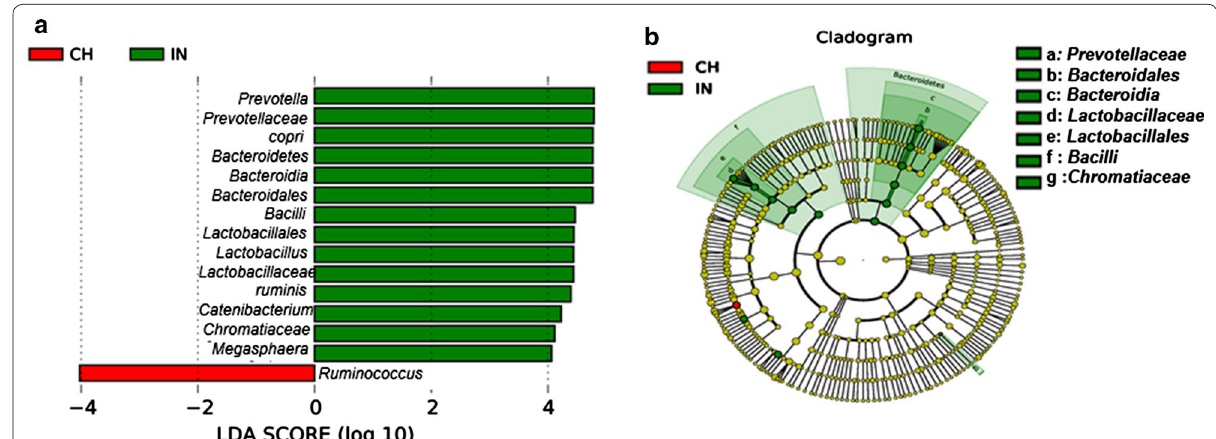
Fig. 6 LEfse analysis identified gut bacterial biomarkers of diet. a The histogram of the LDA scores presents species (biomarker) whose abundance showed significant differences between Indian and Chinese adults. The length of each bin, namely, the LDA score, represents the effect size i.e. the extent to which a biomarker can explain the differentiating phenotypes between groups. b In cladogram, circles radiating from inner side to outer side represents taxonomic level from phylum to genus (species). Each circle’s diameter is proportional to the taxon’s relative abundance. Red nodes refer to the bacteria contributed a lot in Chinese adults, green nodes refer to the bacteria dominant in